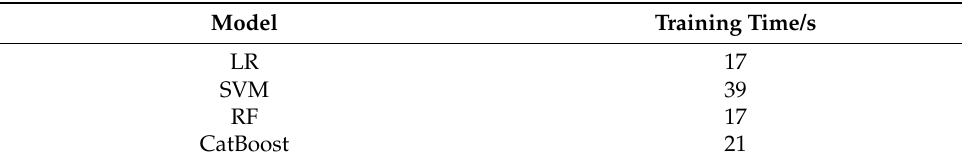
Table 9. The training time of different